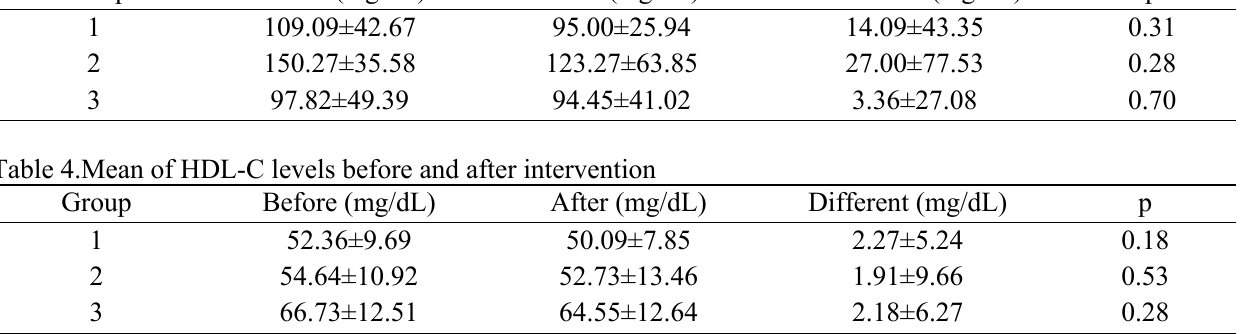
Table 3. Mean of triglyceride levels before and after intervention Group